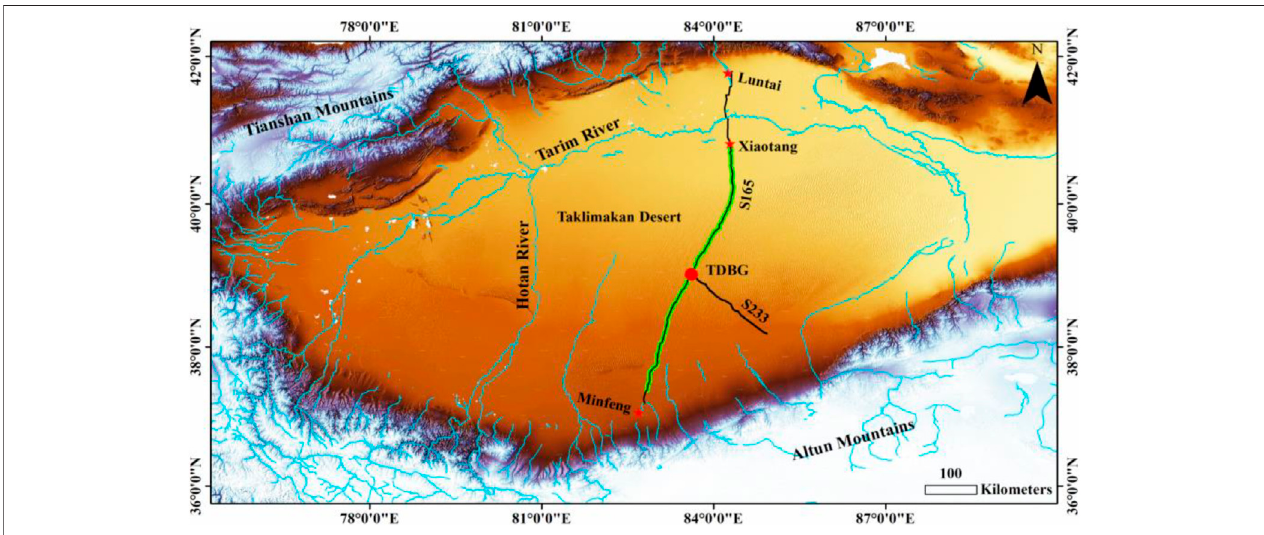
FIGURE 1 | Map of the Taklamakan Desert Highway and the Taklamakan Desert man-made ecosystem. The black line represents the desert highway, which crossesthe Taklamakan Desert from Luntai County toMinfeng County. The green lines from Xiaotangto Minfeng on both sides ofthe highway representthe man-made shelterbelt. The red solid point represents the Taklamakan Desert Botanic Garden\.